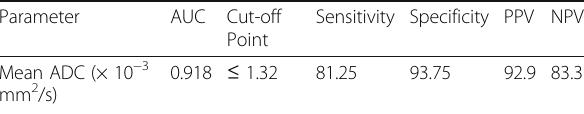
Table 5 Diagnostic performance of ADC value x 10-3 in discrimination of acute pancreatitis and